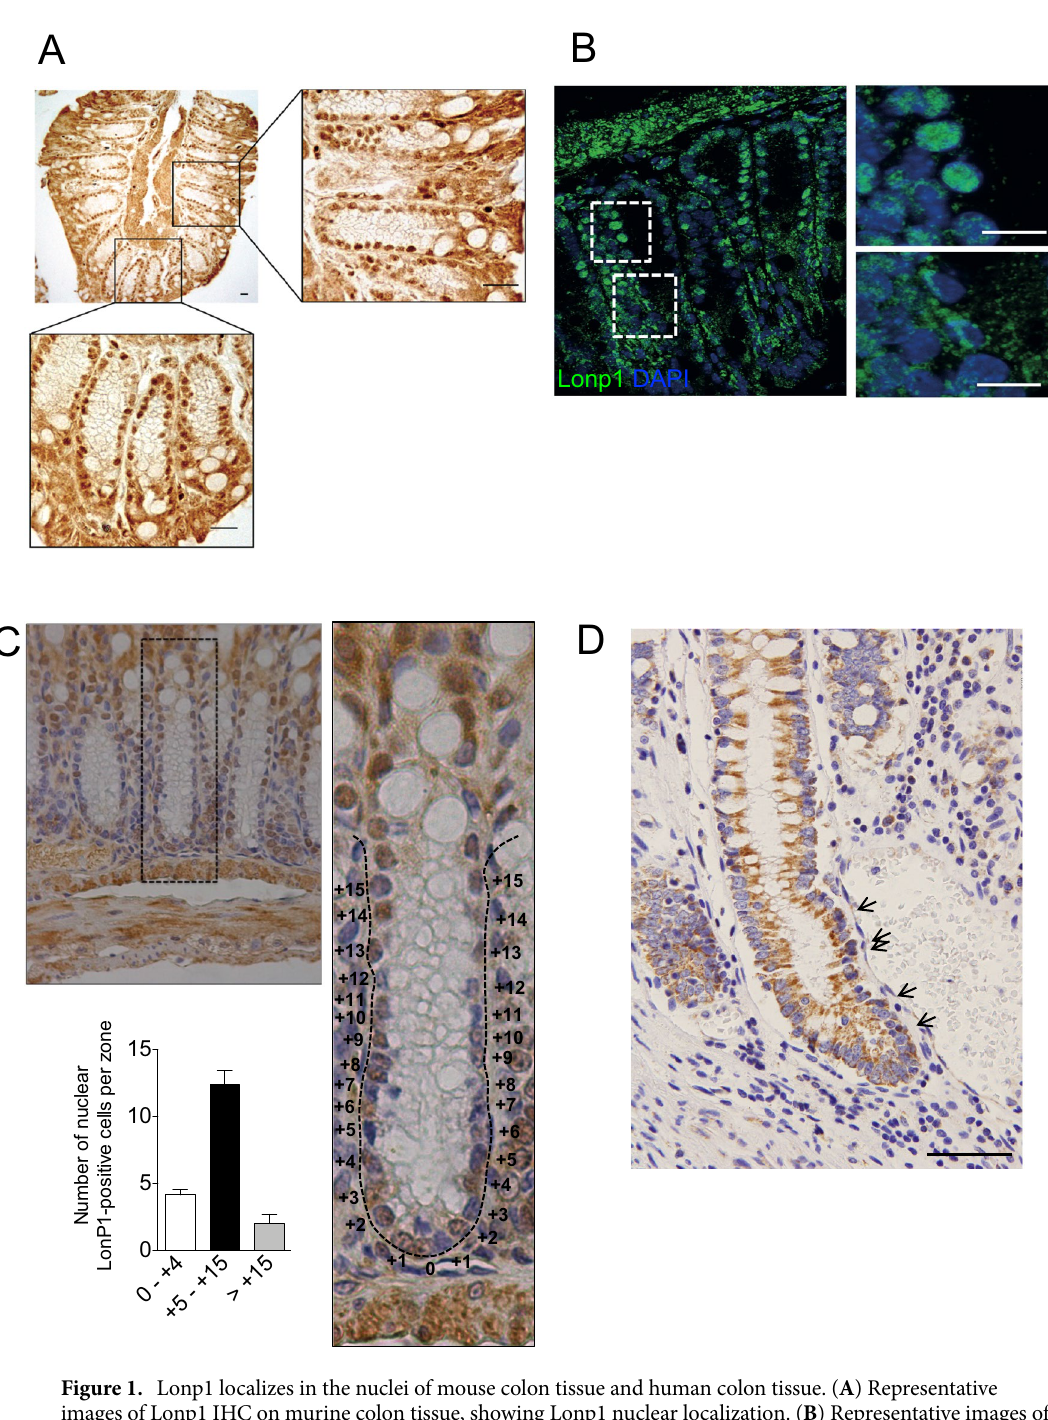
of Lonp1 nuclear expression within the crypts showed that positivity of Lonp1 was concentrated in the transient amplifying (TA) cell area (+ 5 to + 15; Fig. 1C). We therefore analysed Lonp1 subcellular localization in human colon tissue, and also found Lonp1 human nuclear localisation (Fig. 1D; indicated by arrows).